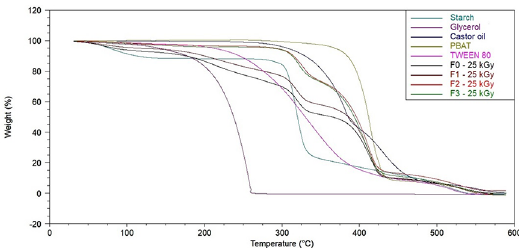
Figure 2. Thermogravimetric curve of blends irradiated at 25 kGy and their